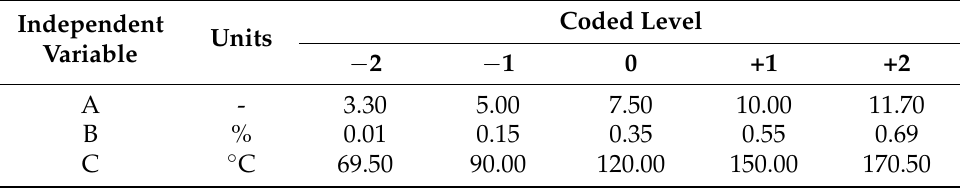
Table 8. Summary of independent variables and their coded levels.